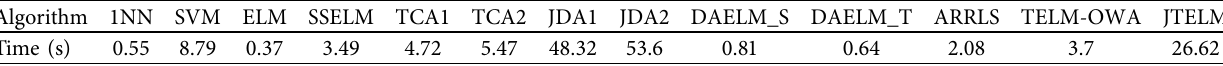
Table 4: Time consumption of all the methods on MNIST vs USPS.